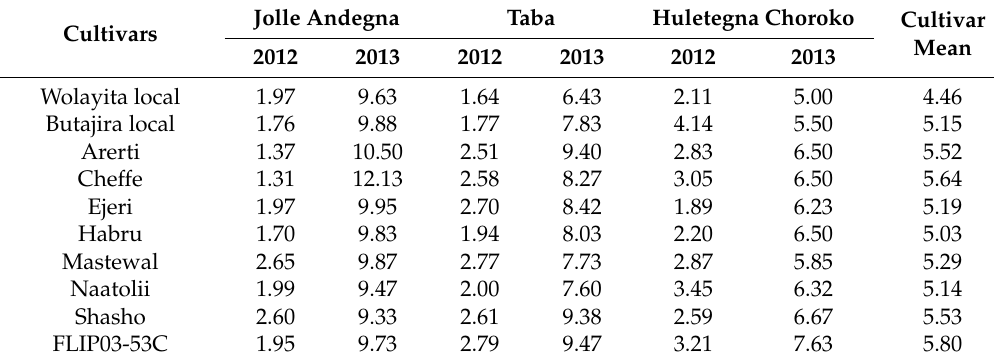
Table 3. Aboveground biomass (t · ha − 1 ) of 15 chickpea cultivars and breeding lines tested under zinc fertilized soil across three locations in southern Ethiopia during the 2012 and 2013 growing